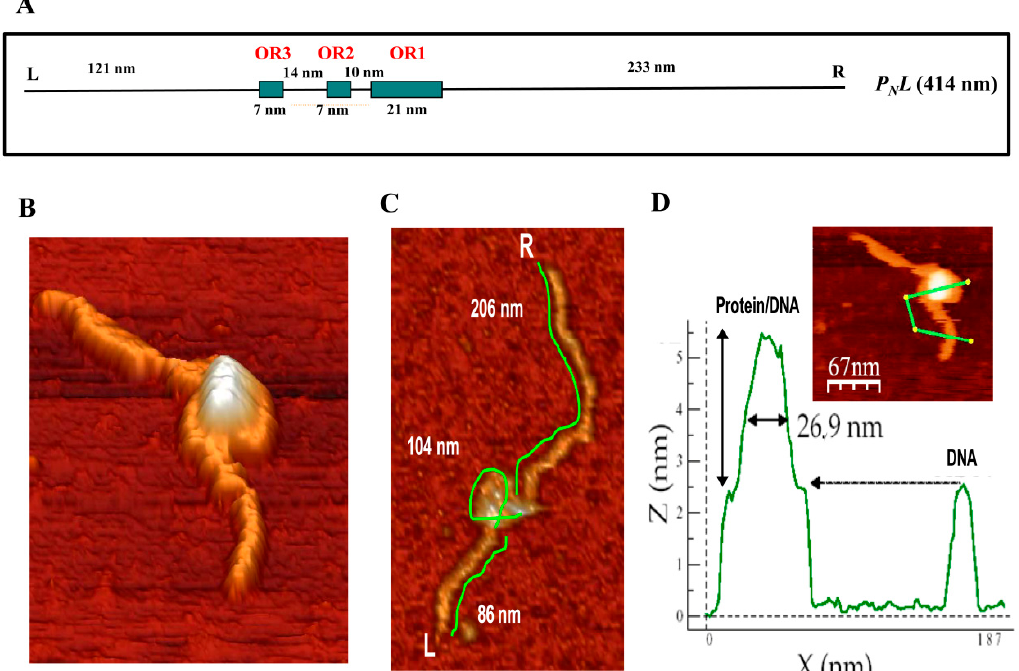
Figure 7. Analysis of the binding of BzdR to the P N promoter by atomic force microscopy (AFM). ( A ) Scheme of the P N L DNA fragment used as a template. The DNA fragment extends from position − 505 to + 720 with respect to the transcription start site of the P N promoter. The operator regions recognized by BzdR are represented by green boxes with their corresponding numbers (OR1, OR2, and OR3). The distances separating each of the indicated regions, the extension of each operator region in nm, and the left (L) and right (R) ends of the P N L fragment are also indicated. ( B ) Image of a superstructure of the BzdR / P N L complex. ( C ) Analysis of distances in a BzdR / P N L superstructure (one image, n = 16). The distances of both arms and the loop of the superstructure are detailed. L and R indicate the left and right ends of the P N L DNA fragment, respectively. ( D ) Image of a BzdR / P N L superstructure and its corresponding height profile. The green line of the image corresponds to the profile outlined in the lower graph. In the graph, the length (in nm) of the line is represented on the x -axis and the height on the y -axis. The first peak corresponds to the BzdR / P N L superstructure and the second peak corresponds to the naked DNA.